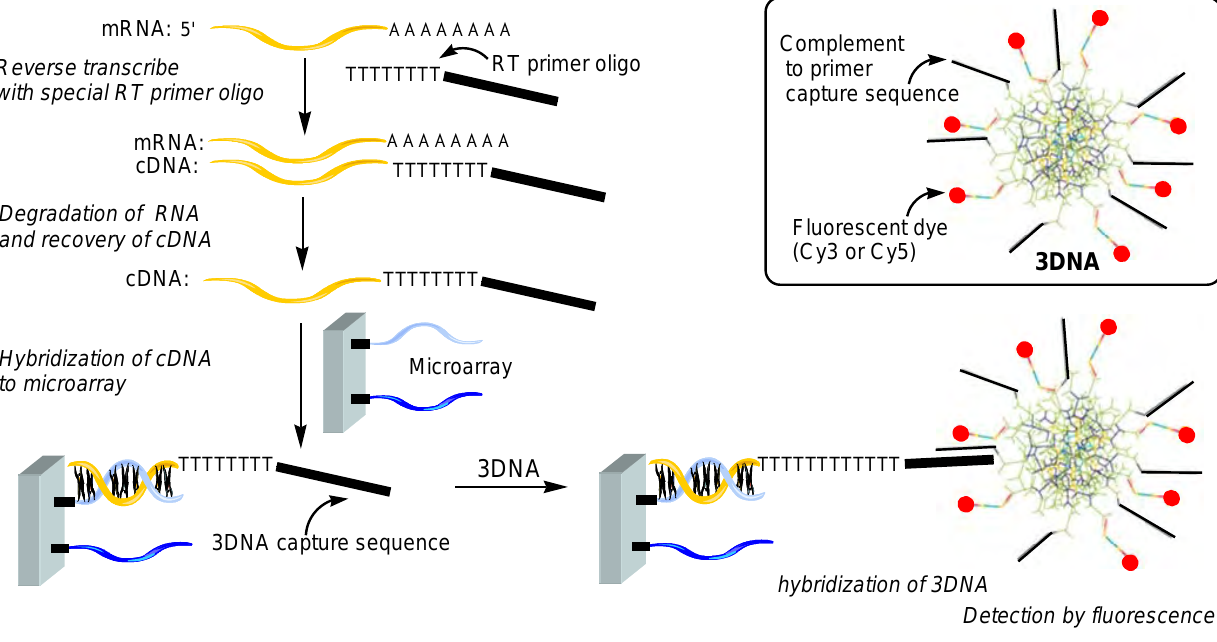
Figure 14. Use of 3DNA dendrimers bearing ~ 45 fluorescent dyes (Cy3, Cy5, Alexa Fluor 546, or Alexa Fluor 647) and oligo/conjugate with application specificity for the indirect labeling of